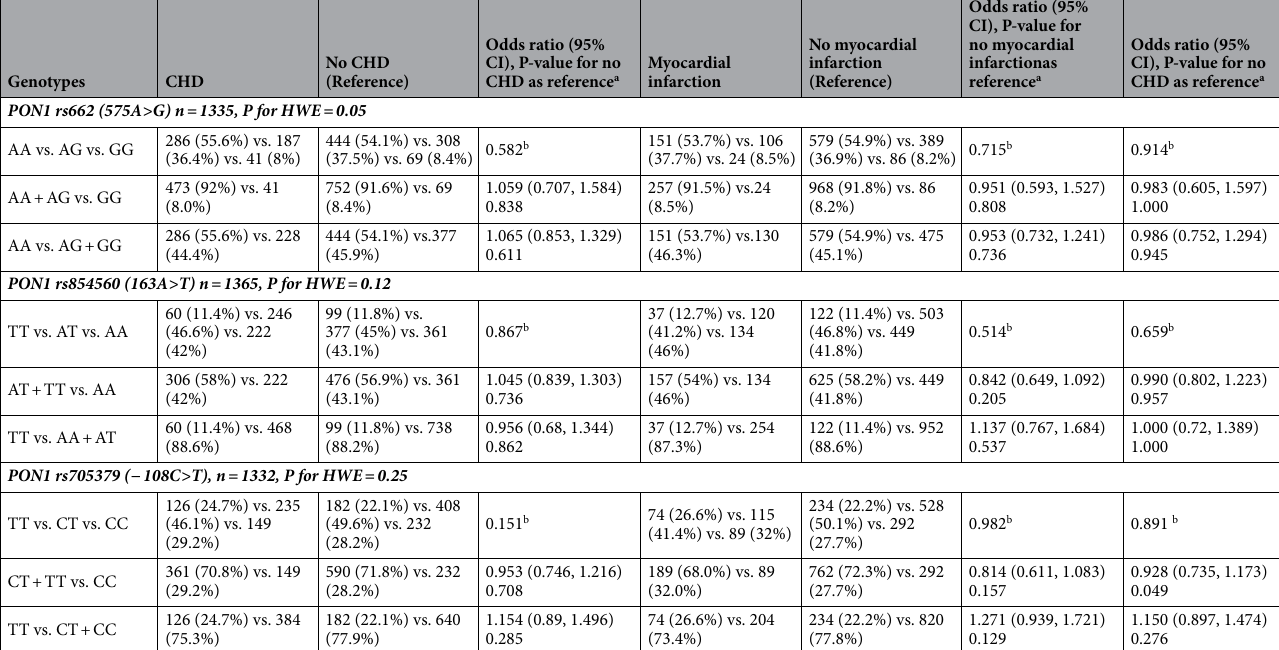
Table 5. PON1 polymorphic variants and the cerebral stroke prevalence in HD patients. HD haemodialysis, PON1 paraoxonase 1 gene. a Fisher’s exact test. b Cochran-Armitage test. c Sample power for this analysis.